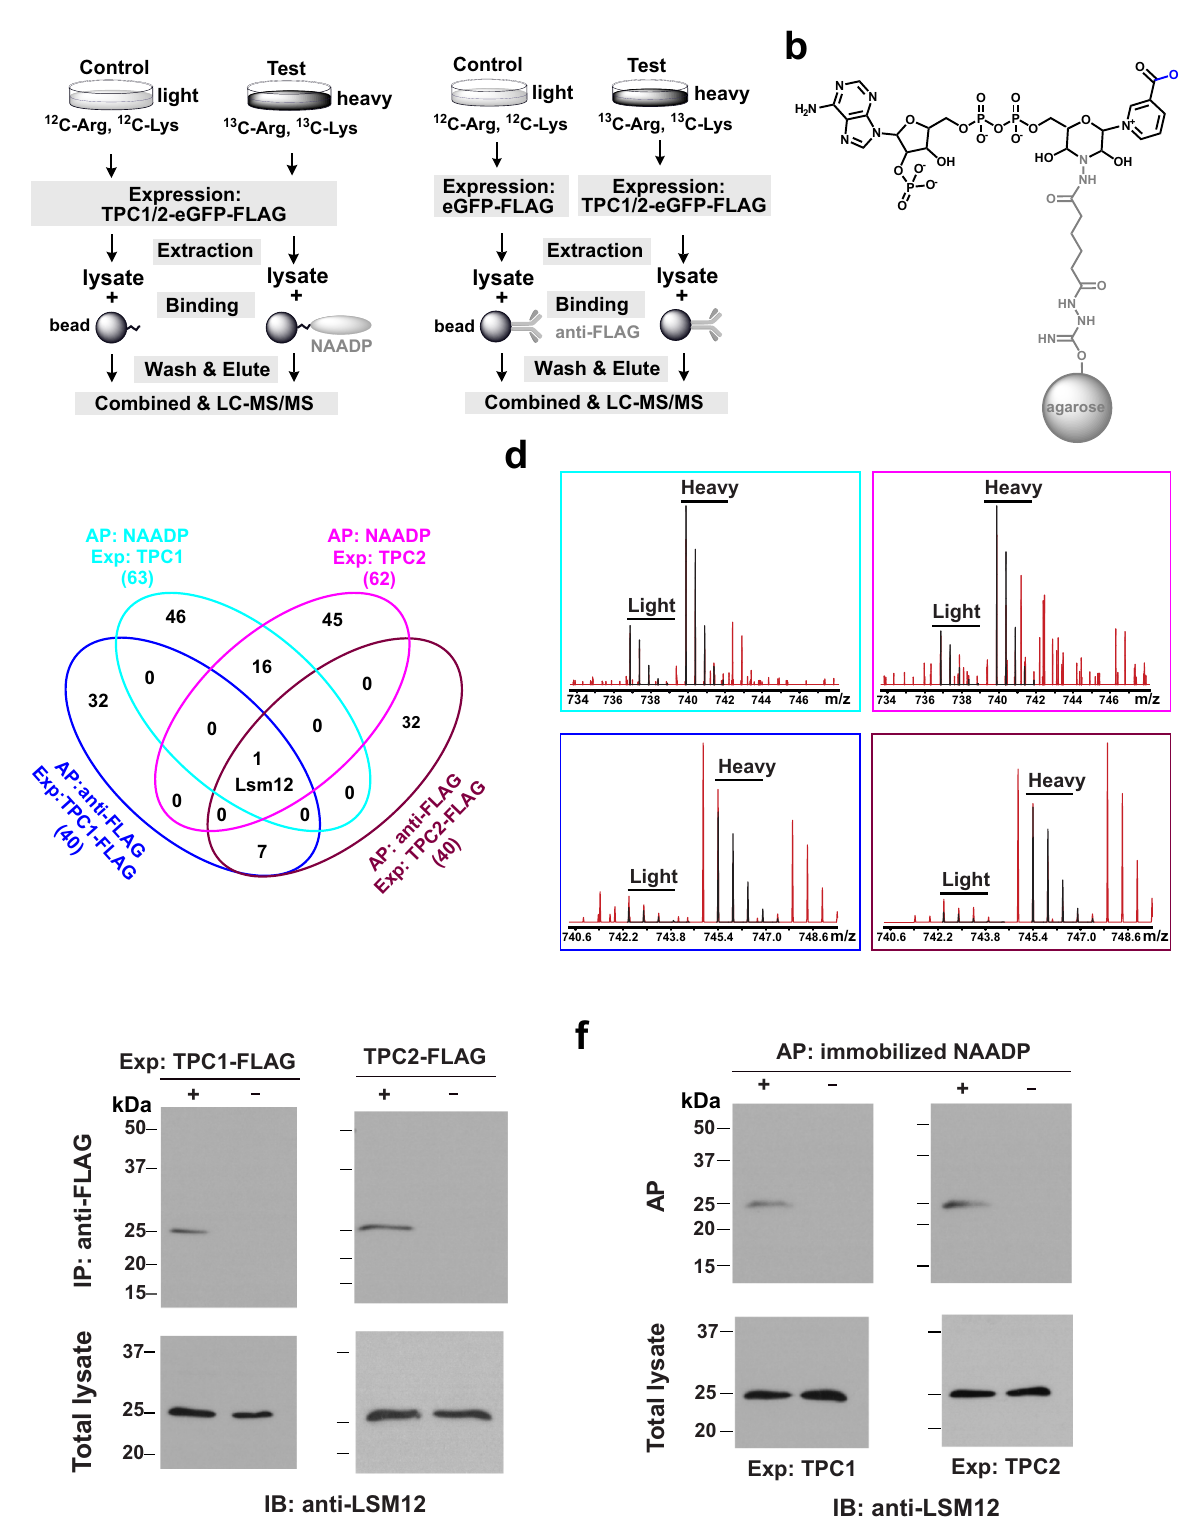
Fig. 1 Identi fi cation of Lsm12 as a putative NAADP receptor. a Strategies of af fi nity precipitation- and SILAC-based quantitative proteomic analyses of interacting proteins of NAADP (left) and TPCs (right). b Chemical structures of immobilized NAADP. c Numbers of overlapping and non-overlapping putative interacting proteins identi fi ed by MS in the indicated four types of af fi nity-precipitated samples. d Representative heavy-light peak pairs (black) of Lsm12 peptides. Peptide SQAQQPQKEAALS 194 (top) was identi fi ed in the samples af fi nity-puri fi ed by immobilized NAADP from TPC1- and TPC2- expressing cells. Peptide LQGEVVAFDYQSK 37 was identi fi ed in the TPC1 and TPC2 complexes af fi nity-puri fi ed by an anti-FLAG antibody. e Immunoblot of endogenous Lsm12 in samples immunoprecipitated by an anti-FLAG antibody from cells expressing FLAG-tagged TPC1 or TPC2. f Immunoblot of endogenous Lsm12 in samples pulled down by immobilized NAADP from TPC1- and TPC2-expressing cells. AP af fi nity-precipitation. Exp. transient expression, IB